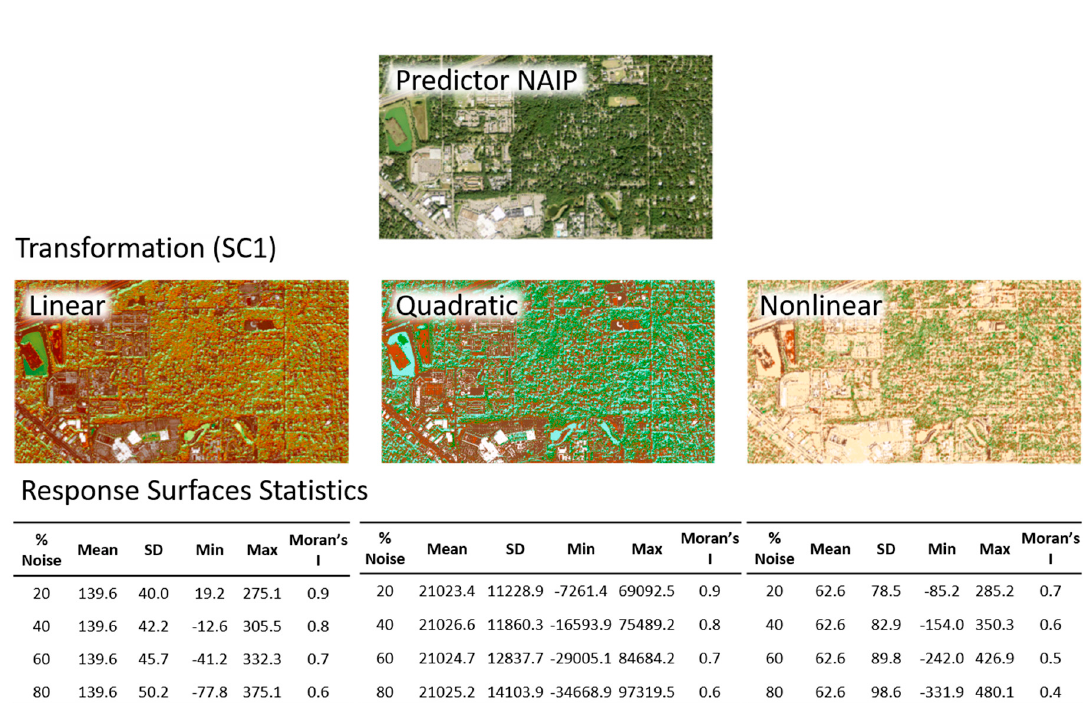
Figure 2. Depiction of the NAIP, Linear, Quadratic, and Nonlinear transformations (SC1). Beneath each SC1 depiction, cell mean, standard deviation, minimum, maximum, and global Moran’s I [37] (rook neighborhood) statistics are presented by the amount of random error (% Noise) introduced within each response surface.